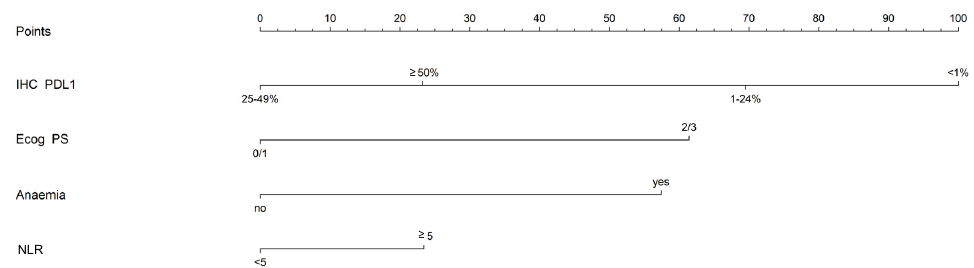
Figure 3. Nomogram for OS prediction. Each variable’s value is associated with a score (points bar on the upper part of the nomogram, Supplementary Table S4). By summing the points corresponding to the different variables included, it is possible to calculate the subject’s total score. When tested on data from the independent set of 67 patients from PSM with complete